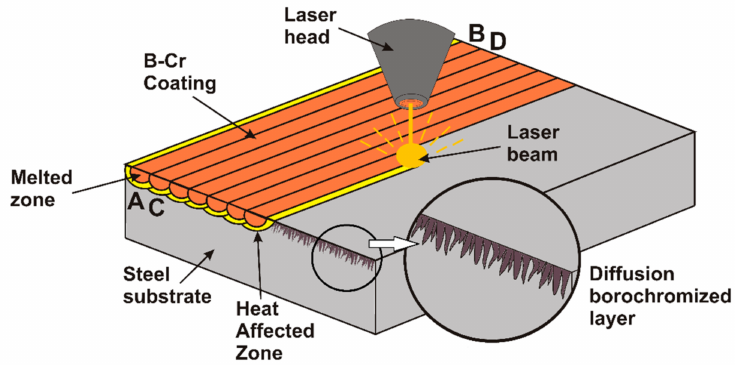
Figure 1. Scheme of laser processing of diffusion borochromized